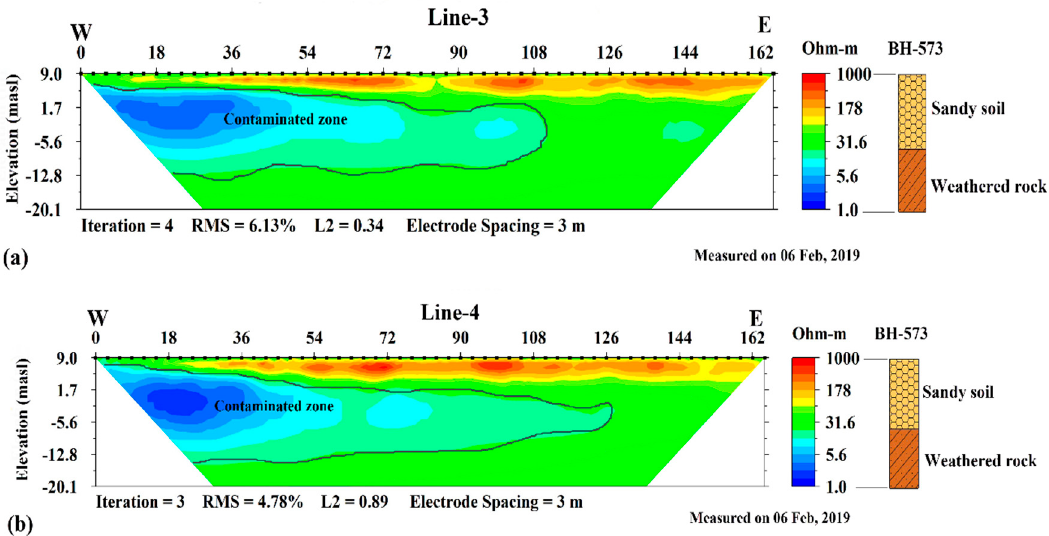
Figure 7. Two-dimensional (2D) ERI result: ( a ) Line-3 and ( b ) Line-4.